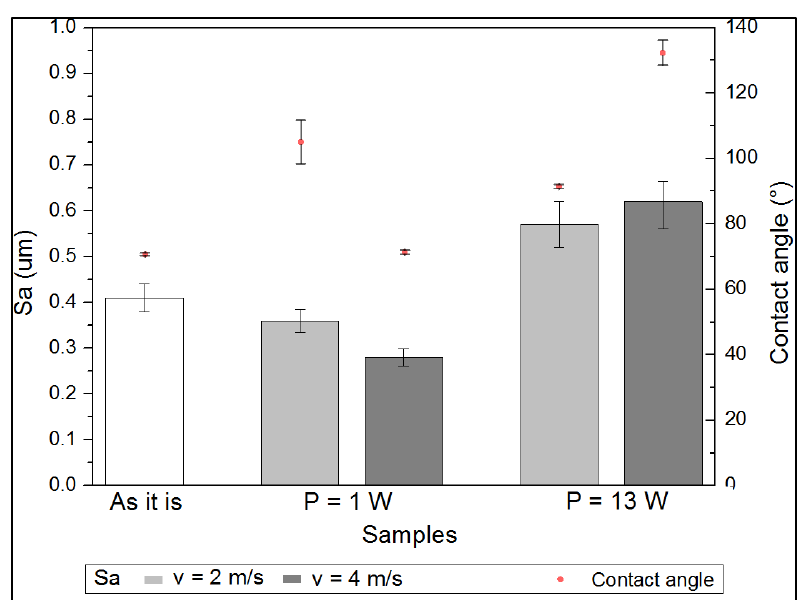
Figure 7. Roughness (Sa) and contact angle values for all tested samples.